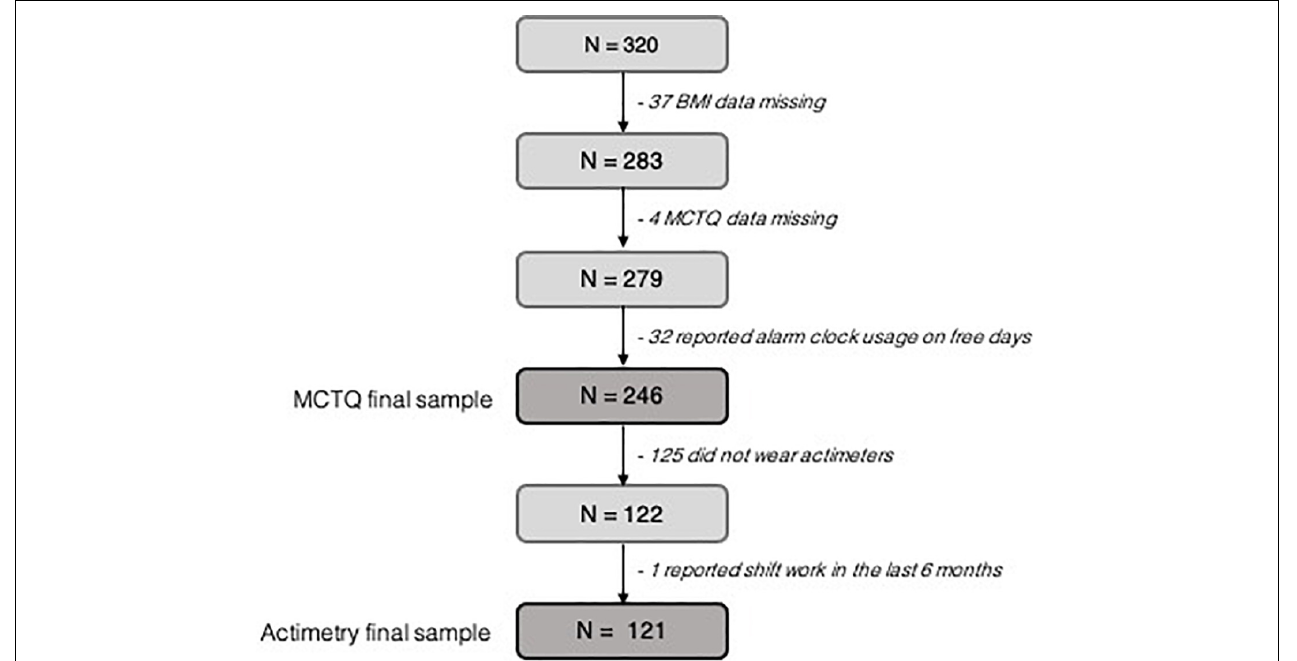
FIGURE 1 | Flowchart of the participants recruitment and selection process. White squares represent final sample